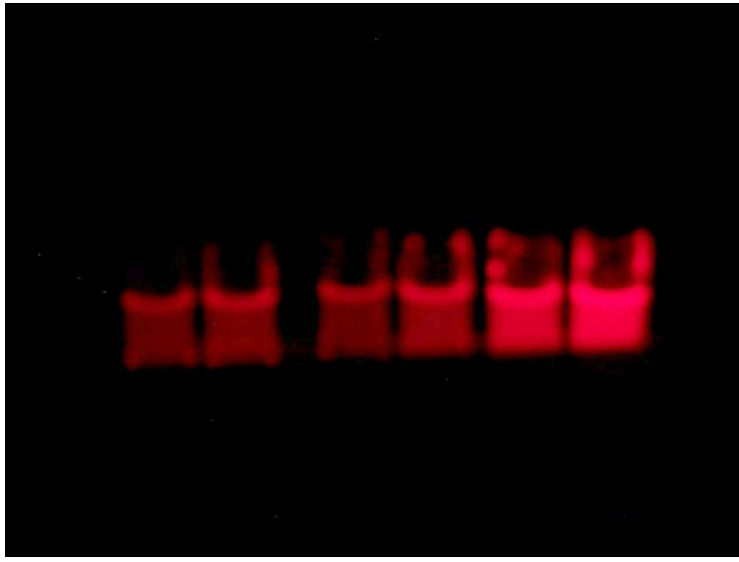
FIGURE 5 . Luminescence photo of Eu-TTFA samples. See text. Left to right in: methanol/water + 1 drop of undiluted paraoxon; methanol + 1 drop of undiluted paraoxon; heptane/water; heptane/water + 1 drop of by 100 diluted paraoxon; heptane/water + 1 drop of by 10 diluted paraoxon; heptane/water + 1 drop of undiluted